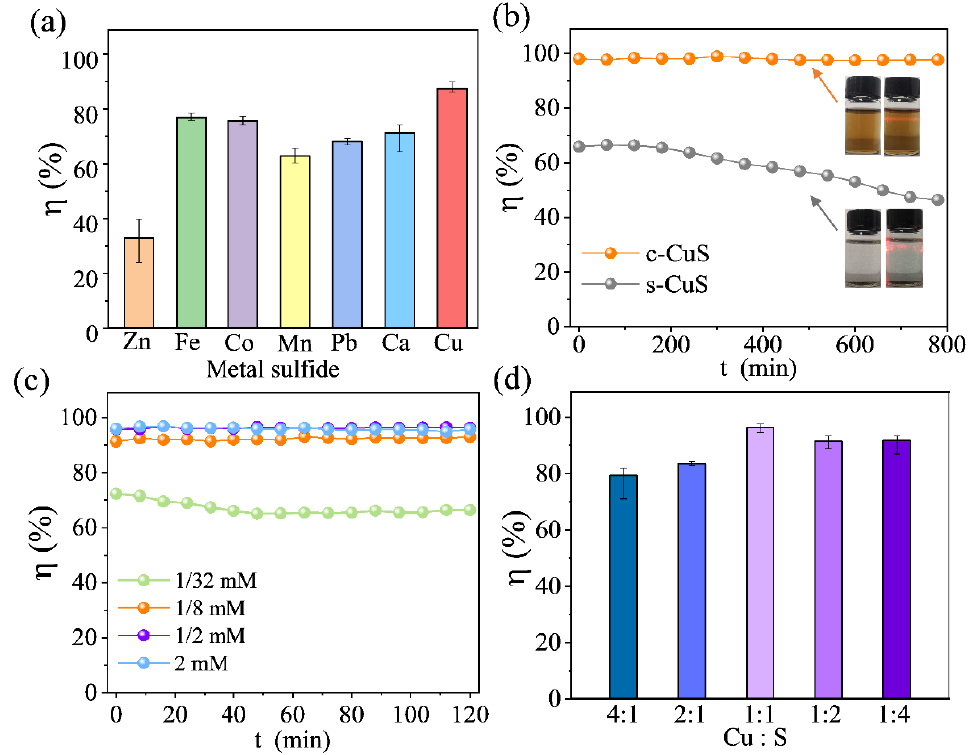
Figure 1. ( a ) Hg 0 removal performances of different TMSs suspensions. ( b ) Long-time Hg 0 removal performances of c-CuS and s-CuS. ( c ) The effect of raw material concentration on Hg 0 removal. ( d ) The effect of Cu and S ratio on Hg 0 removal (Experimental condition: solution volume = 80 mL, solution pH = 3.0, solution temperature = 20 °C, flue gas was pure N 2 , the inlet concentration of Hg 0 was 200 µg·m −3 ).